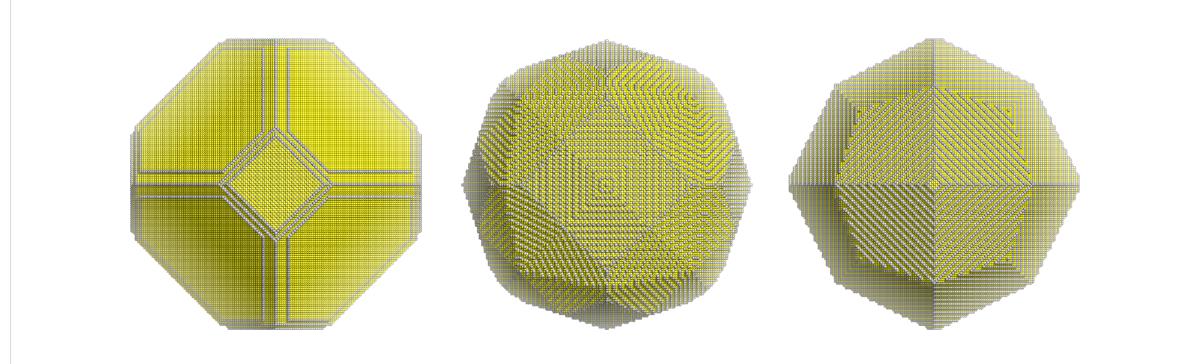
Figure 2: Atomistic Wulff constructions for Au nanoparticles using surface energies published in Refs. [15] and [17]. Atoms that have coordination numbers less than nine are colored in gray. Left: in vacuum or inert environment (28 nm in diameter, 539500 atoms, 2980 of which are step-edge atoms; (111) faces occupy 62% of the total area). Center: In low-pressure CO gas (27 nm in diameter, 533600 atoms, 7610 of which are step-edge atoms; (321) faces occupy 61% of the total area). Right: With adsorbed SCH 3 radicals (29 nm in diameter, 502900 atoms, 10600 of which are step- edge atoms; (211) faces occupy almost 100% of the total area).